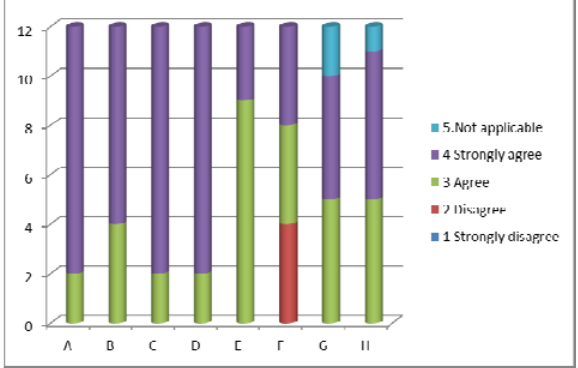
Figure 6. User perceptions on usefulness of MDP web mapping